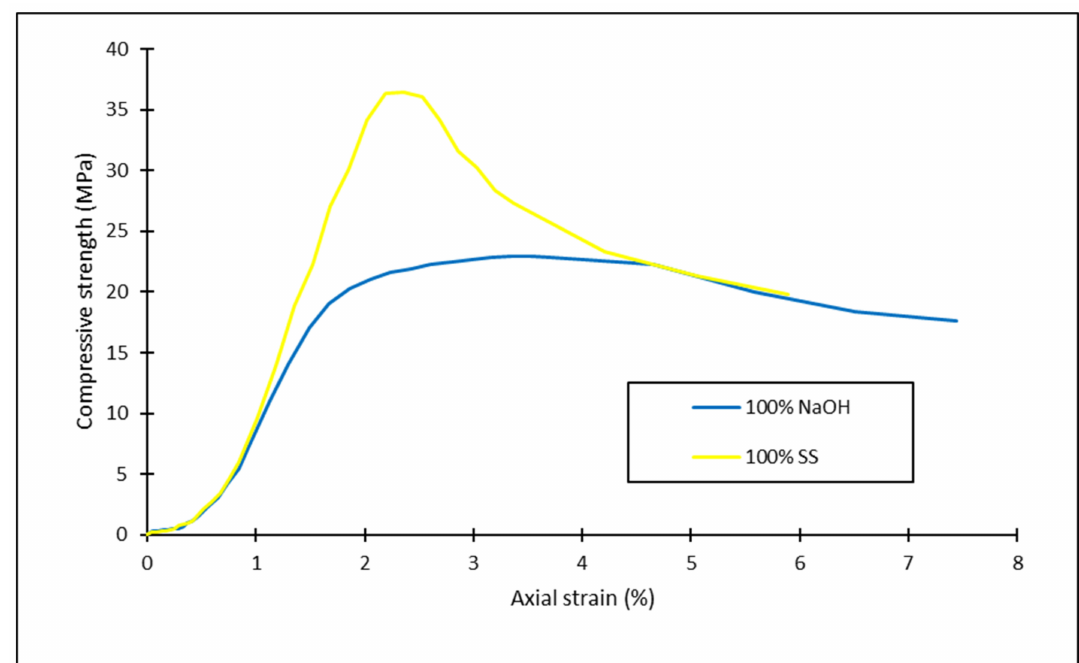
Figure 18. Stress–strain curves of the created geopolymers.